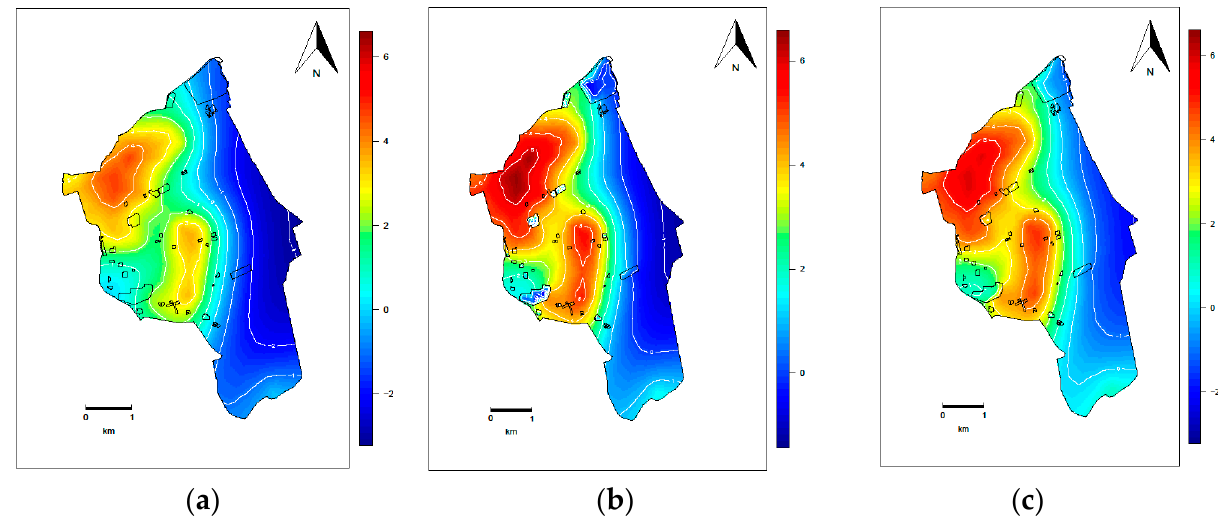
Figure 10. Spatial random fields of different models: ( a ) Spatial random field of stationary Gaussian model; ( b ) Spatial random field of barrier model; ( c ) Spatial random field of Multi-Barriers Model.